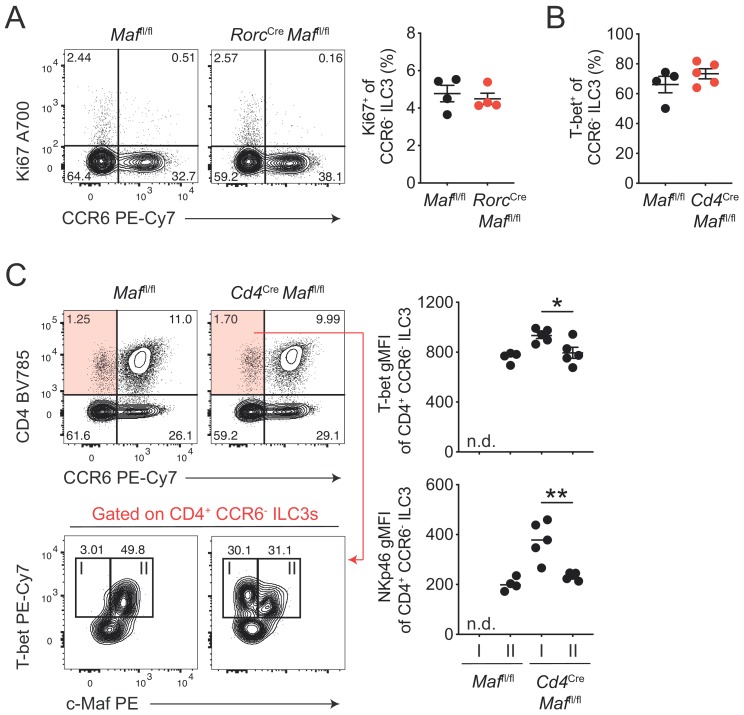
c-Maf cell-intrinsically restrains the type 1 conversion of CCR6- ILC3s.(A) Frequencies of Ki67+ cells among siLP CCR6- ILC3s from RorcCre
Maffl/fl and control mice. Representative contour plots are shown left; graph on the right shows quantification (n = 4). (B) Frequency of T-bet+ cells among siLP CCR6- ILC3s from CD4Cre
Maffl/fl and control mice (n = 4). (C) T-bet and NKp46 expression level (gMFI) of siLP c-Maf- (I) and c-Maf+ (II) CD4+ T-bet+ CCR6- ILC3s from Cd4Cre
Maffl/fl and control mice. Representative flow cytometric profiles of CD4 vs. CCR6 and T-bet vs. c-Maf expression (left); right, quantification (n = 4, mean ± SEM, *p<0.05, **p<0.01). All statistical differences were tested using an unpaired Students’ t-test (two-tailed).